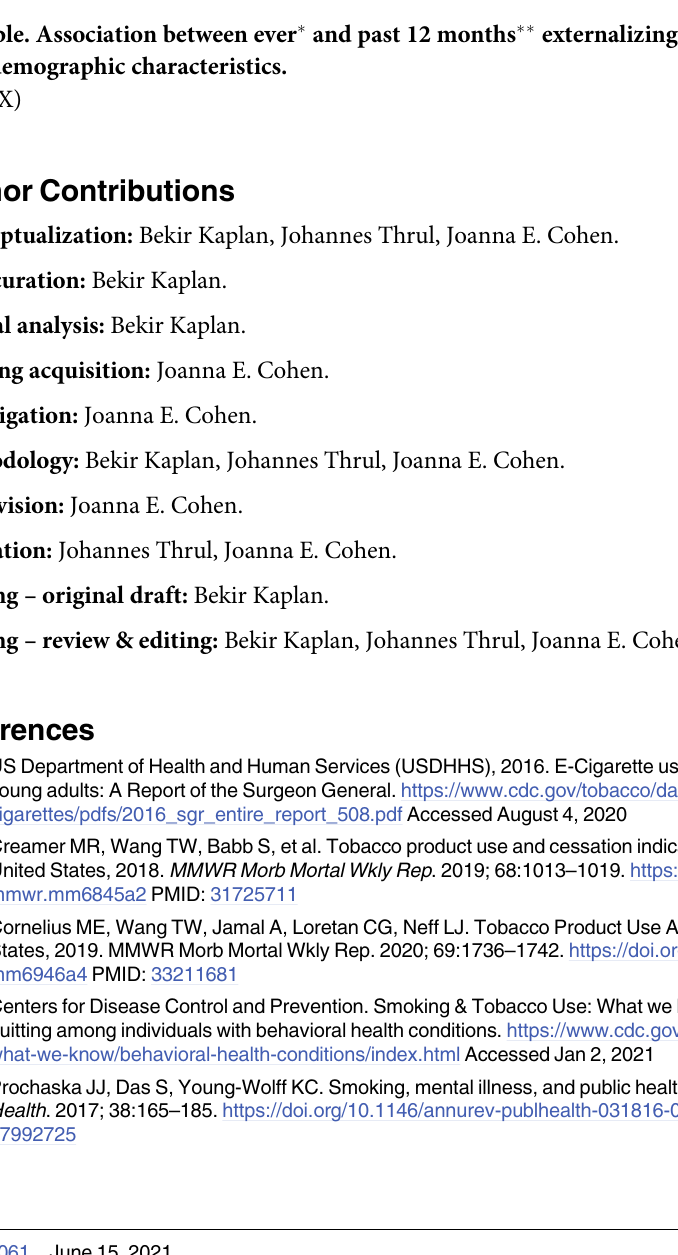
S1 Table. Association between ever � and past 12 months �� internalizing problems and sociodemographic characteristics. S2 Table. Association between ever � and past 12 months �� externalizing problems and sociodemographic